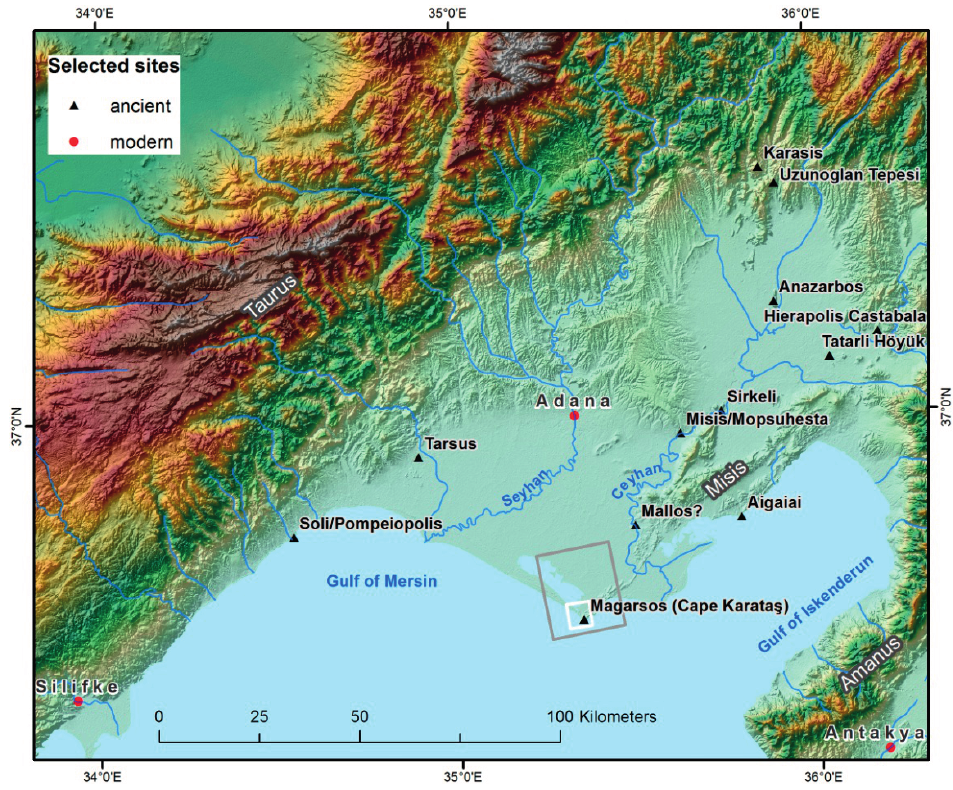
Figure 1. Overview of the broader study area of the Cilician Plain (Çurukova, Turkey) with locations of the most important ancient settlements. The frames indicate the extent of the TanDEM-X data for the site of Magarsos (Cape Karata ş ) (grey = TanDEM-X Stripmap; white = TanDEM-X high resolution Spotlight mode; background: SRTM-C